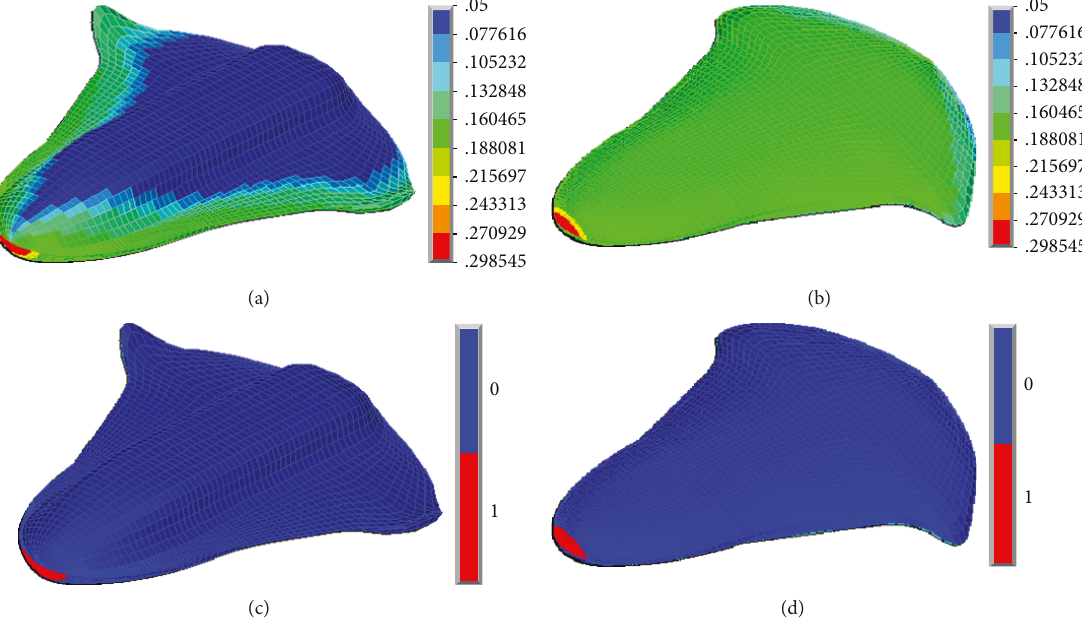
Figure 8: Thickness distribution (m) on the conceptual RLV (a, b); two-material distribution on the conceptual vehicle (c, d) (red color: RCC, blue color: